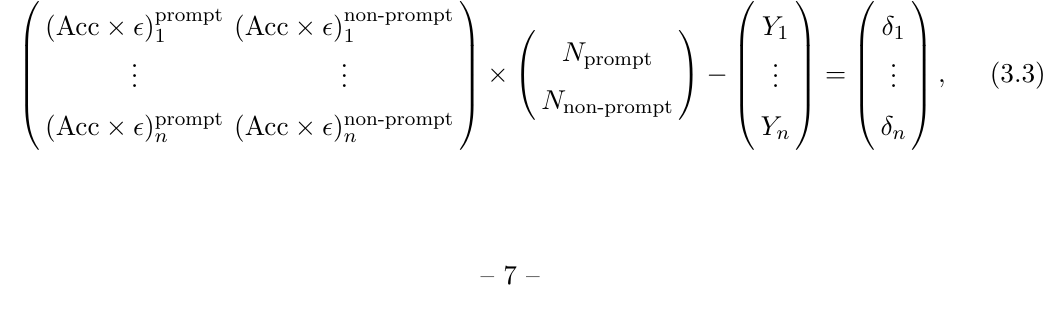
Figure 2 . Acceptance-times-efficiency factor for D 0 , D + , and D + (Acc × (cid:15) ) factors for non-prompt (blue) and prompt (red) D mesons are shown together with their ratio (bottom